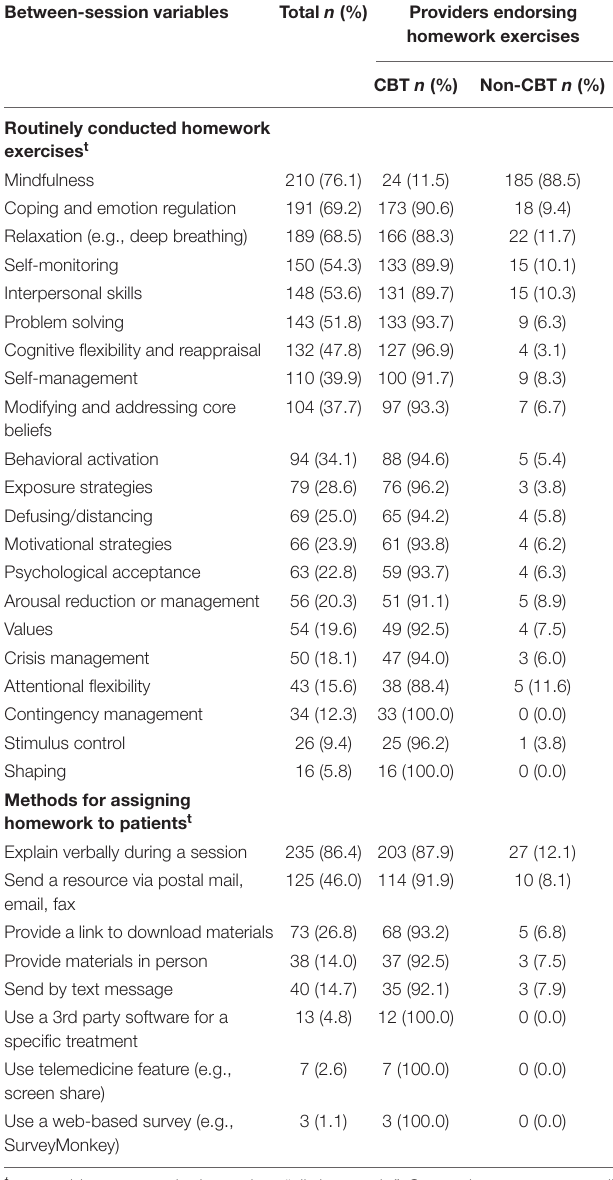
TABLE 3 | Assigning and assessing homework exercises with telemental health patients. Between-session variables